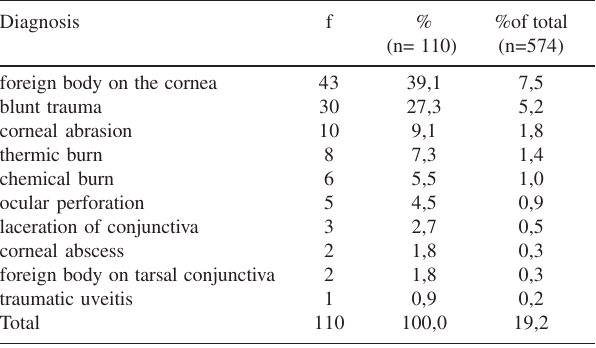
Table 3 - Patients with trauma diagnostics that looked for ophthalmology emergency room of the University of São Paulo Medical School General Hospital